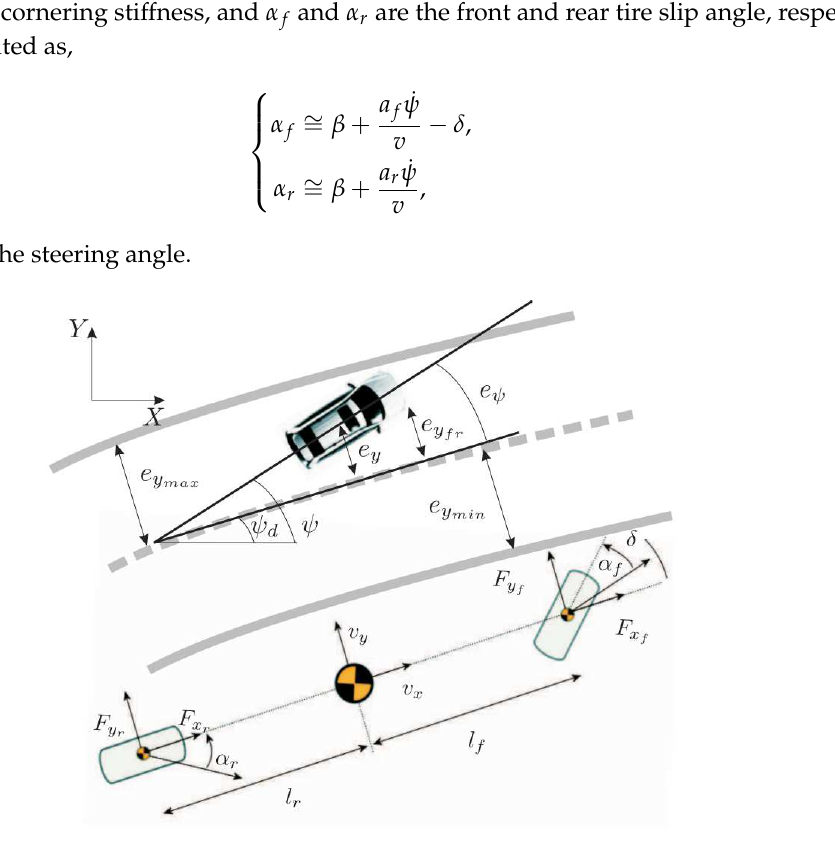
Figure 3. Single track kinematic model of the vehicle.